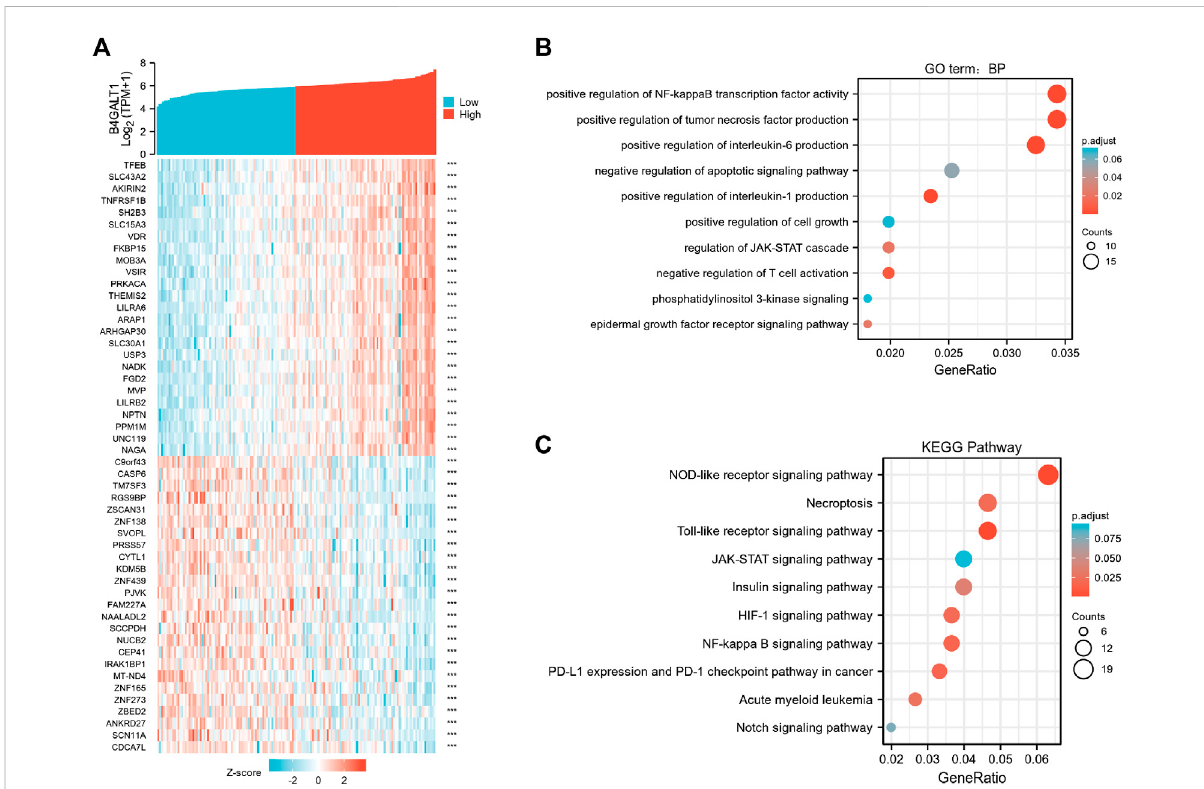
FIGURE 5 Functional clustering analysis of B4GALT1-related genes. (A) Heatmap showing the top 50 genes in acute myeloid leukemia (LAML) that were positively and negatively related to B4GALT1. Red represents positively related genes, and blue represents negatively related genes. (B) Enriched GO terms in the “ biological process ” category; (C) KEGG pathway annotations. The B4GALT1-axis represented the proportion of DEGs, and the Y -axis represented different categories. The different colors indicate different p values, and the different sizes represent gene numbers.